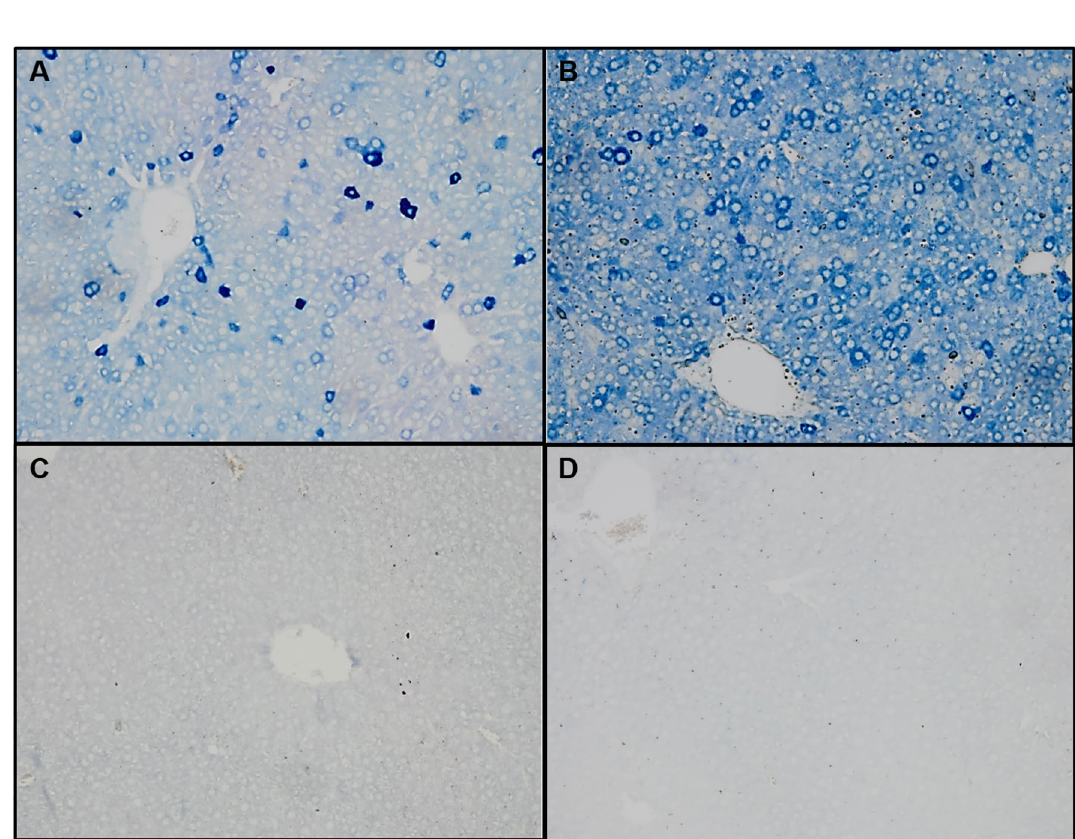
Figure 6. ATX immunohistochemistry of mouse livers after transduction with AAV8-CMV-ATX ( A ) and AAV8-HLP-ATX ( B ) constructs. ( C ) ATX is undetectable in non-transduced mouse liver. ( D ) Staining control using liver sample of the same mouse as in ( B ), leaving out the primary anti-ATX antibody. 10 × magnification for all